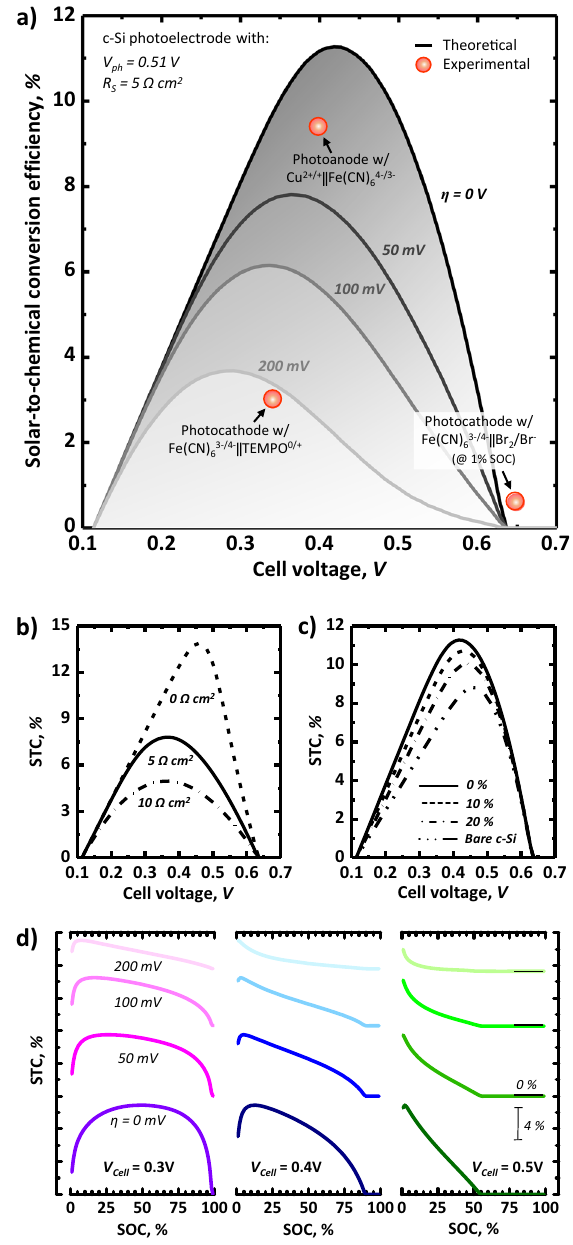
Fig. 5 Theoretical STC% limits with experimental values. a The photo- charging ef fi ciency at 10% SOC is plotted as a function of the thermodynamic potential for different kinetic overpotentials ( η = 0 V, 50 mV, 0.1 V, 0.2 V). The system is modeled as a c-Si photoelectrode with a photovoltage (V ph ) of 0.51 V and a series resistance (R S ) of 5 Ω cm 2 . The red circles indicate the experimentally measured value with various redox couples from Fig. 4 b , c correspond to the model curves for different R S and re fl ection from the surface, respectively, and d demonstrates SOC- dependant STC% with varied cell voltage and